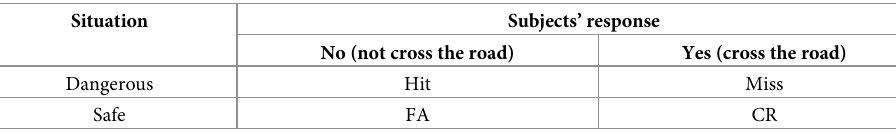
Table 3. Signal detection theory